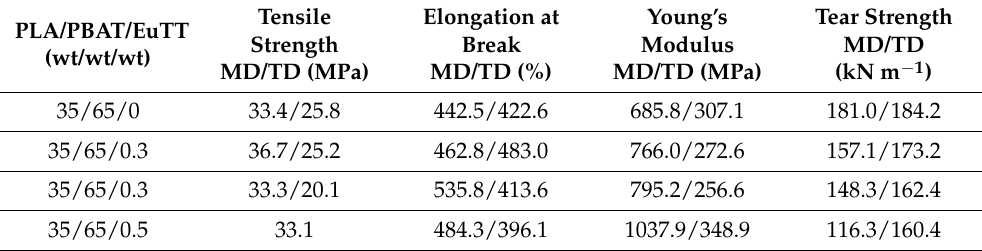
Table 2. Mechanical properties of PLA/PBAT and PLA/PBAT/Eutt films. Adapted with permission from ref. [28]. Copyright 2018 Wiley Online Library.